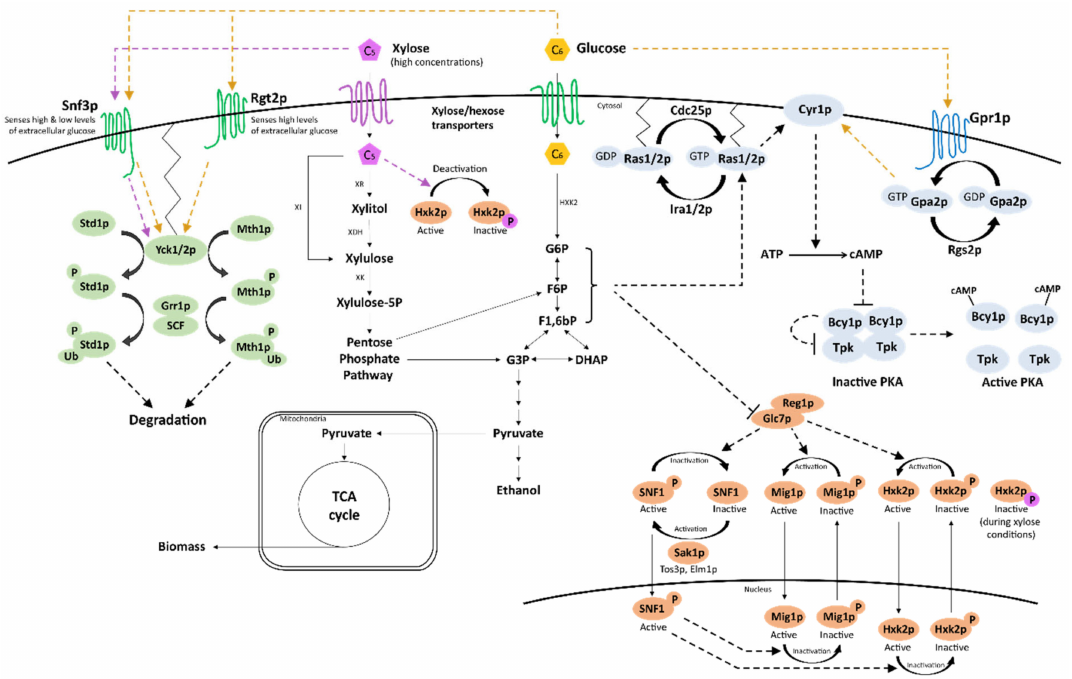
Figure 6. Model of D -xylose sensing and signaling in S. cerevisiae compared to known D -glucose signaling events. D -Xylose may be sensed by Snf3p, but not by Rgt2p or Gpr1p. D -Xylose metabolism has been shown to result in a decreased glycolytic flux when compared to D -glucose [238,239], which in turn will affect the concentration and signaling strength of the glycolytic intermediates G6P (glucose-6-phosphate), F6P (fructose-6-phosphate) and F1,6bP (fructose-1,6-bis-phosphate). Hxk2p is phosphorylated in two different positions depending on the origin of the signal: phosphorylated in Ser15 by SNF1, and autophosphorylated in Ser158, triggered by absence of D -glucose and presence of D -xylose, respectively [36]. Dashed purple arrows: D -xylose signaling; dashed orange arrows: D -glucose signaling; black dashed arrows: downstream signaling events (irrespective of sugar stimulus); arrows with arrowheads: induction or activation; arrows with hammerheads: repression or deactivation; solid arrows: metabolic or transport reactions; circles with P: phosphorylations (the color of the circle indicate which signaling pathway controls the phosphorylation); purple pentagons: D -xylose; yellow hexagons: D -glucose. Green shapes: Snf3p/Rgt2p pathway; blue shapes: cAMP/PKA pathway; orange shapes: cAMP/PKA pathway. Partially adapted from